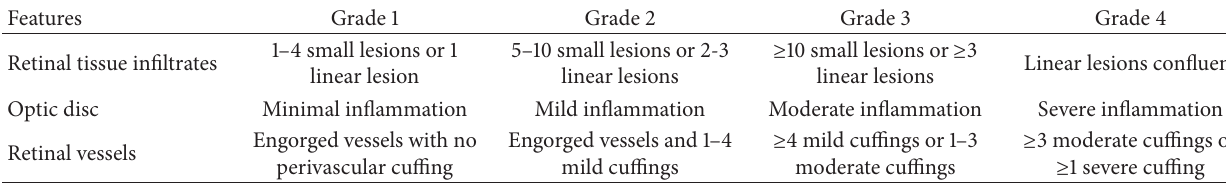
Table 1: Clinical evaluation of retinal changes during EAU.